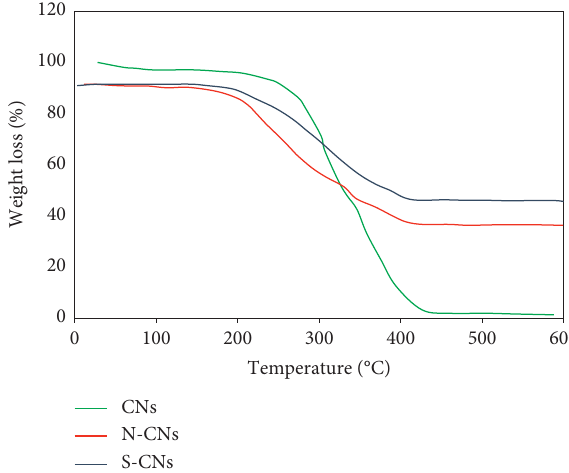
Figure 6: TGA analysis of CNs, N-CNs, and S-CNs.